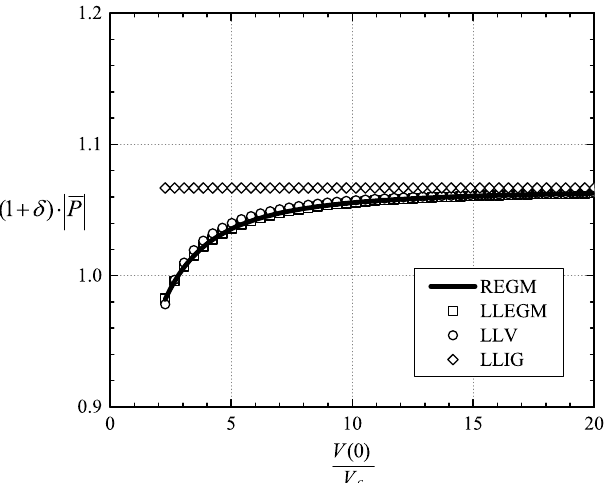
Figure 8. Scaled loss vs. reference specific volume V (0)/ V c at T ref = 1.25 T c . The speed number Λ = 50 and the parameter δ =